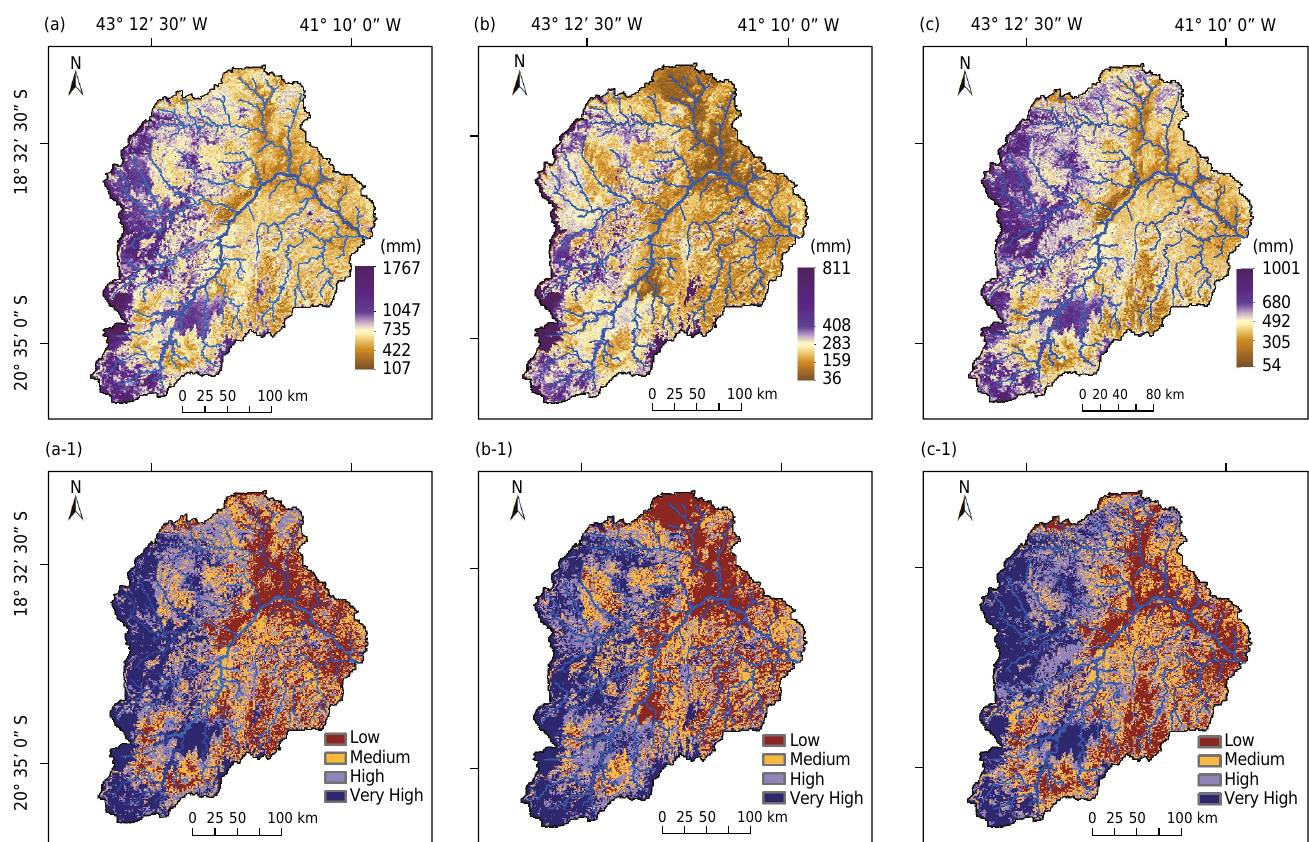
Figure 9. Potential groundwater recharge (PGR) in the Doce River Basin in the years 2007/2009 (a), 2007/2008 (b), and 2008/2009 (c) and respective maps of the PGR